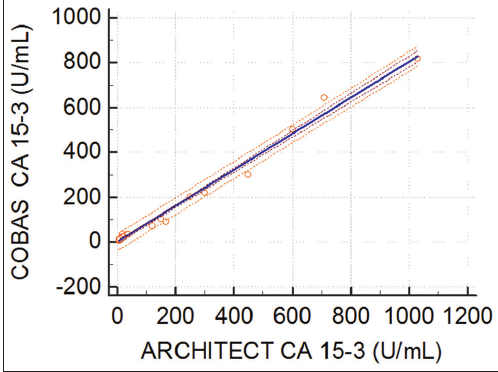
FIGURE 1. Comparison of cancer antigen (CA) 15-3 anti- gen determined in human serum samples using ARCHITECT i2000SR immunoassay analyzer and Cobas E 601 analyzer (r =